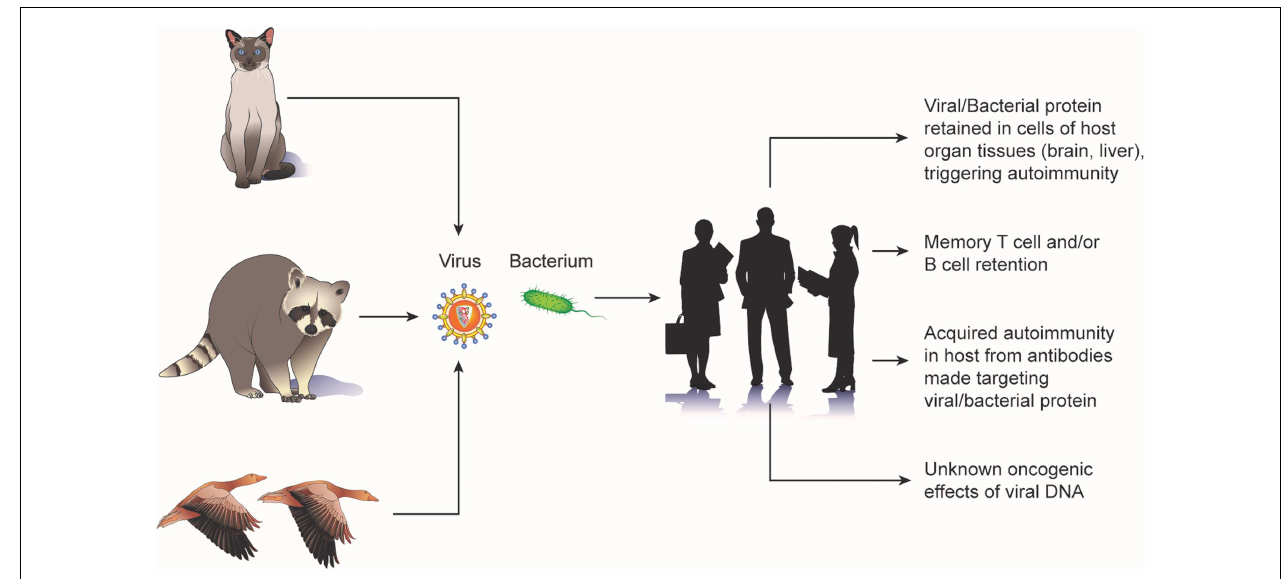
FIGURE 1 | Potential mechanisms of carcinogenic “biologic memory” retained from exposure to animal viruses and bacteria